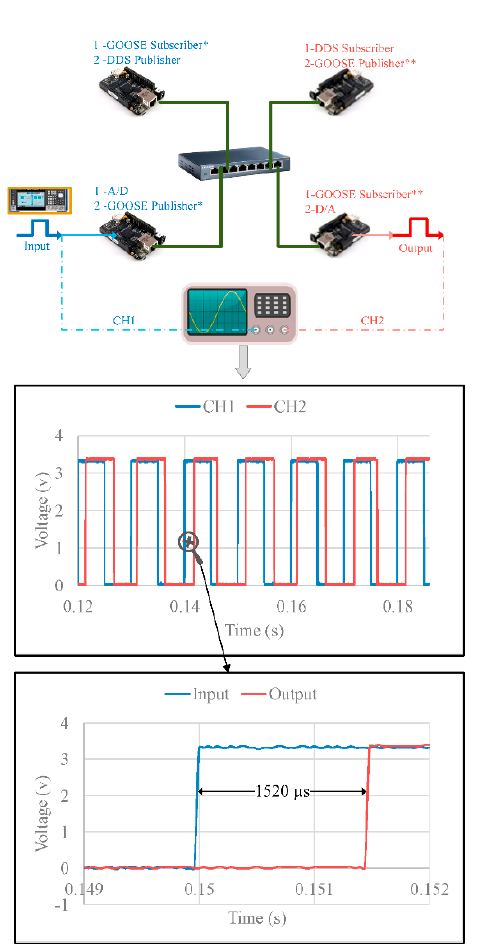
Figure 6. Results from Case 2.